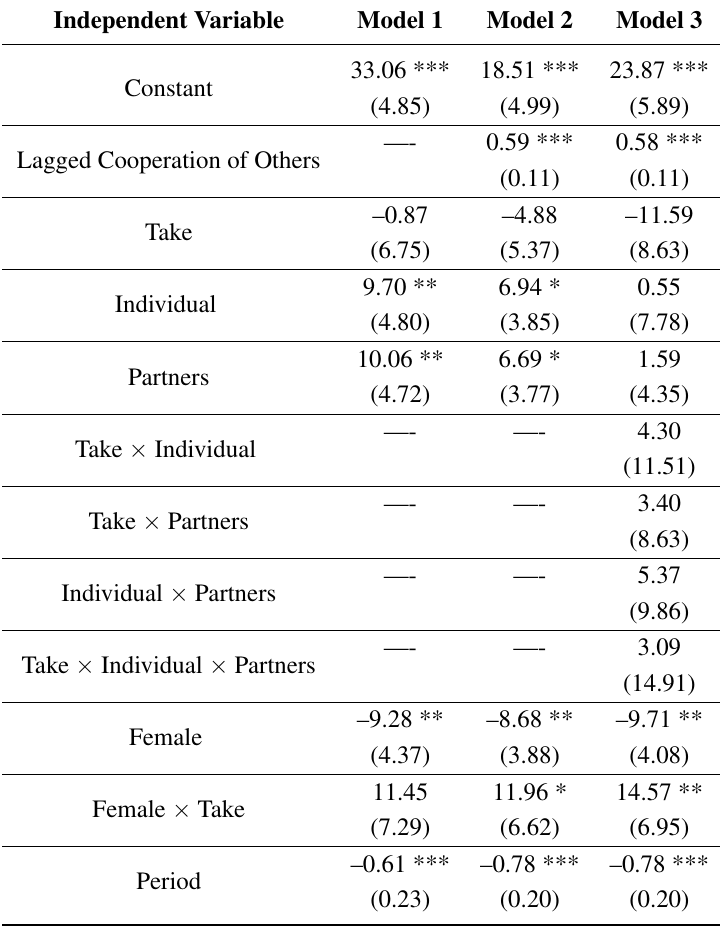
Table 6. Tobit Regressions for Cooperation Interacting Gender with Take